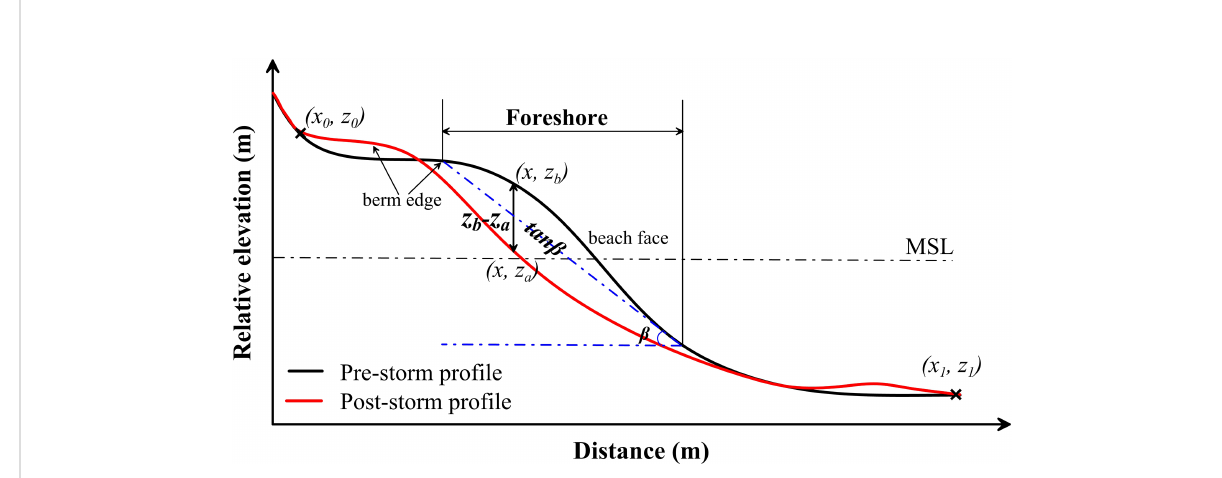
FIGURE 2 De fi nition sketch of mean pro fi le change and beach slope ( tan b ). MSL is the mean sea level, modi fi ed from Qi et al. (2010).